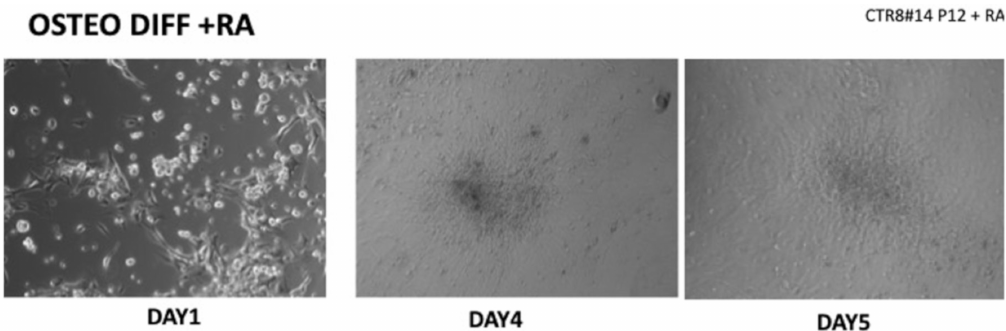
Figure 2. Once the EBs were ready they were plated in an osteogenic di ff erentiating medium that allowed them to mature into osteoblasts; we can see from the images how, from the first days, the cells showed the typical morphologies of osteoblasts. The 8 + RA control (cell clone) in the osteogenic di ff erentiation medium initially showed rapid growth, as seen from the optical microscope images. (magnification 20 × –10 × , plates 70,000 cells). We see clone growth at 1, 4 and 5